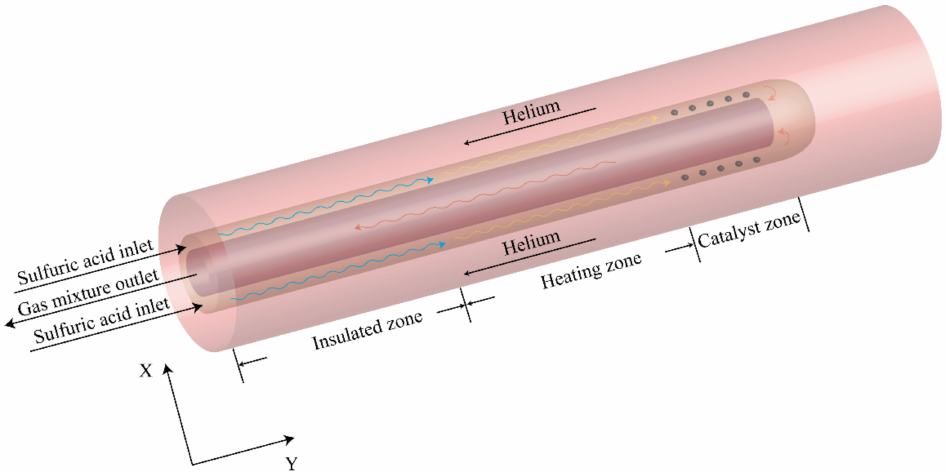
Figure 1. Geometric model of bayonet heat